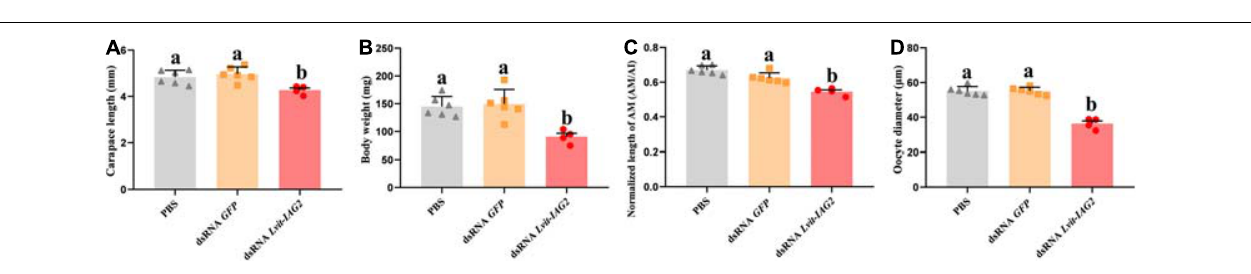
FIGURE 5 | Effects of long-term Lvit-IAG2 silencing on gene expression of L. vittata . The effectiveness of gene knockdown in the long-term Lvit-IAG2 silencing experiment was evaluated by qRT-PCR. The expression levels of Lvit-CFSH1 , Lvit-CFSH2 , Lvit-GIH1 , Lvit-GIH2 , Lvit-CHH , Lvit-Vg, and Lvit-VgR were detected following in vivo injection with PBS, dsRNA GFP or dsRNA Lvit-IAG2 . The gene expression levels were standardized by Lvit- β -actin expression levels and represented as mean ± SEM (“a, b, and c,” p < 0.05; one-way ANOVA followed by Tukey’s multiple range tests; n = 4–6).